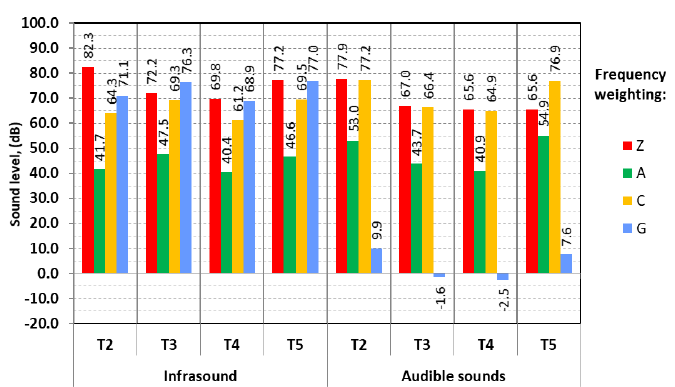
Figure 18. Comparison of equivalent noise levels weighted by various curves in the infrasound and audible band.